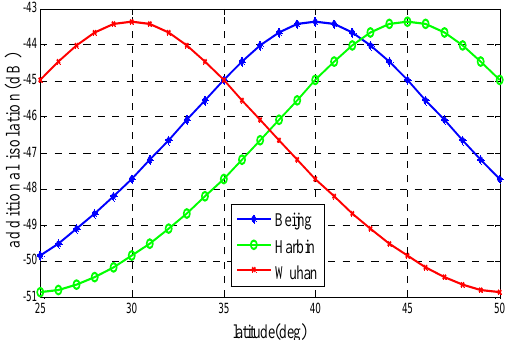
Fig. 6. Additional isolation needed for different